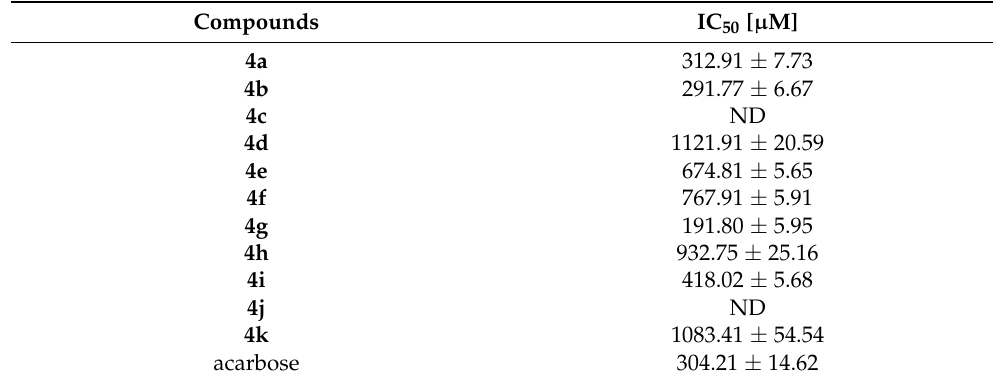
Table 6. α -glucosidase inhibitory activity of the